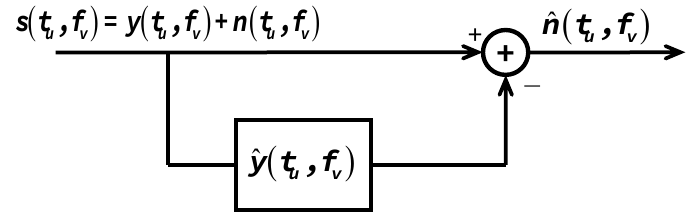
Figure 5. RFI mitigation technique: an estimation ŷ ( t substracted from the received signal